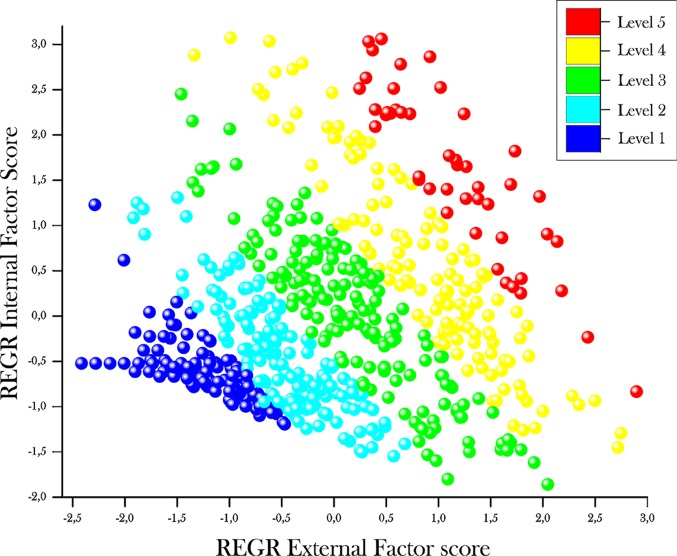
Discriminant analysis scatter plot of the two factors model. Recoded external factor scores (x-axis) are plotted against recoded internal factor scores (y-axis). Different grey intensities represent distinct subject levels of performance as indicated in the figure inset.